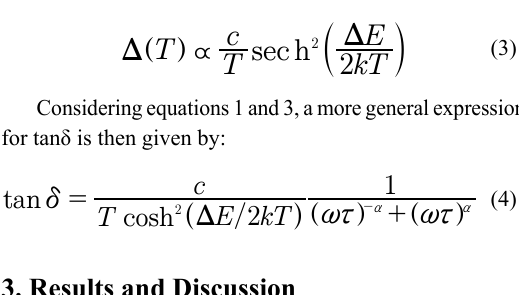
Figure 2. DMA spectra of the pocket containing Pyr at two different frequencies. The continuous line is a fit according to eqs 1−4 for the thermally activated